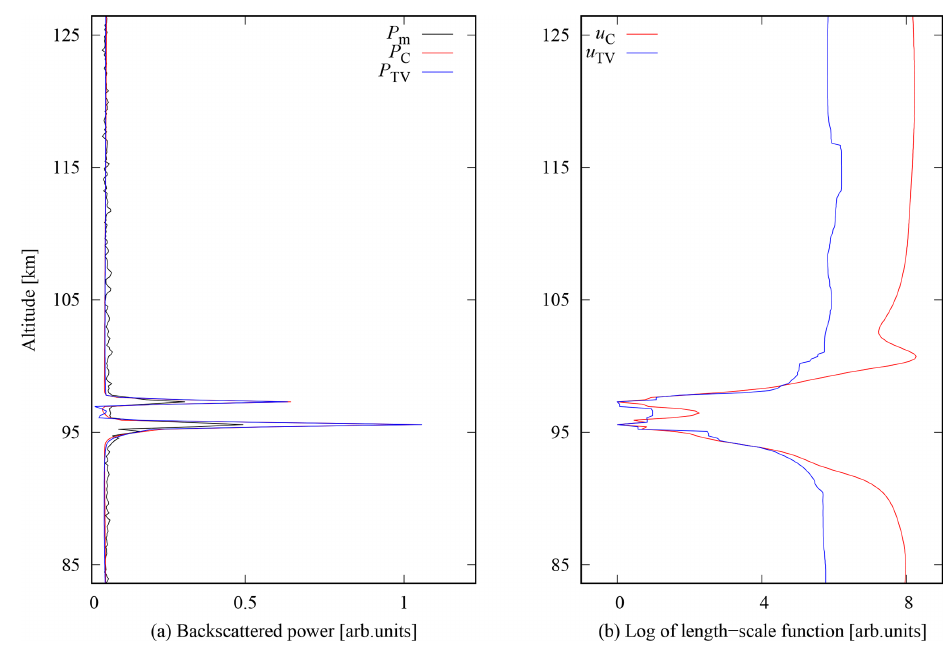
Figure 8. PMSE EISCAT data from 12 August 2018, at exactly 00:16:19UT. Panel (a) shows the comparison between the reconstructions of the unknown signal P with the Cauchy difference prior (red line), with tuning parameter α C = 2 . 5 and TV (blue line) prior, with α TV = 5 . 0. The backscattered power profile after matched filtering P m is plotted with black line. Panel (b) shows corresponding values of the length- scale functions in logarithmic